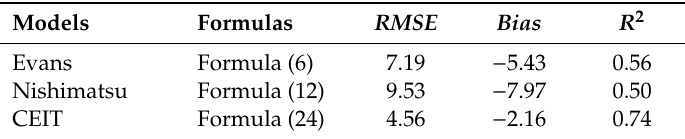
Figure 15. Comparisons of the performance of different models in estimating the peak cutting forces in cutting hard rocks. Table 3. Values of root mean square error ( RMSE) , bias , and R 2 for each model in predicting the experimental results in